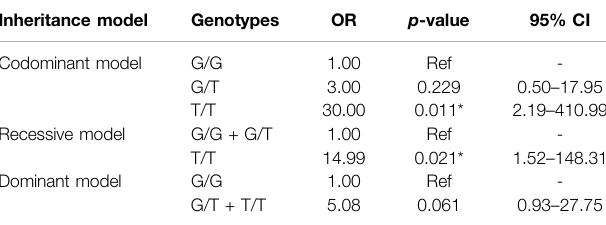
TABLE6| Univariatelogisticregressionbetween CYP2B6 c.516G > T(rs3745274) and CNS toxicity (nightmares, insomnia, anxiety, and suicide attempt grouped) in EFV-treated patients. Inheritance